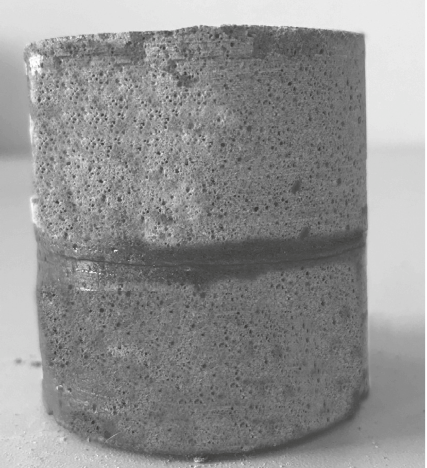
Figure 3: Test model to determine shear parameters of the surface of a grout-infilled flaw.